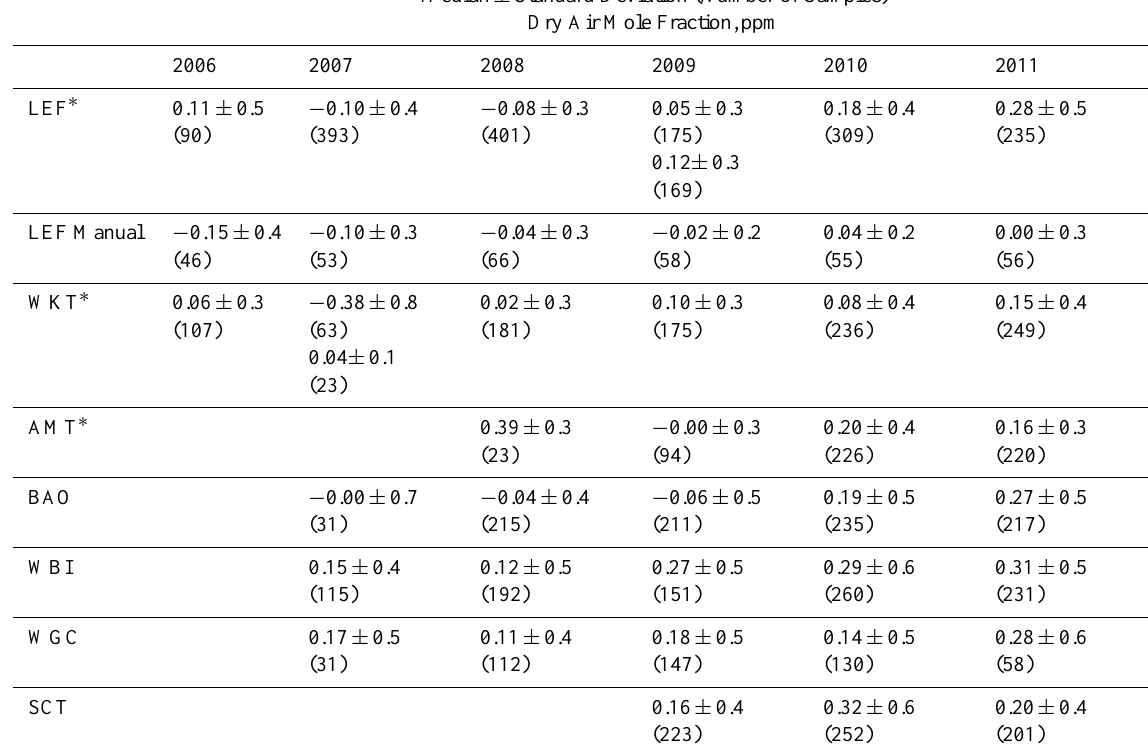
Table 5. Annual summary of flask minus in situ χ CO